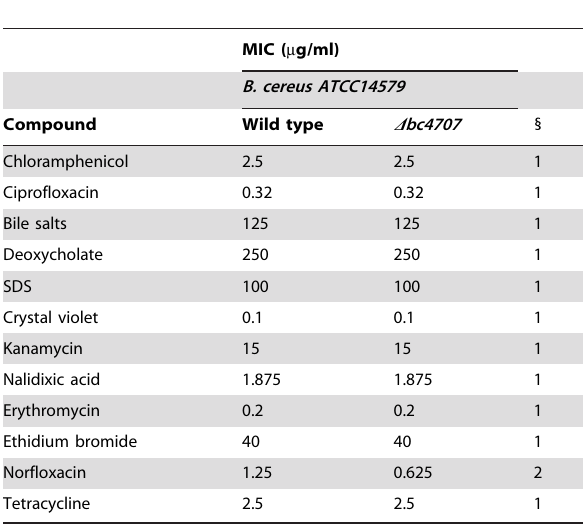
Table 2. Susceptibilities of B. cereus ATCC14579 (wild type) compared to its isogenic D bc4707 mutant.